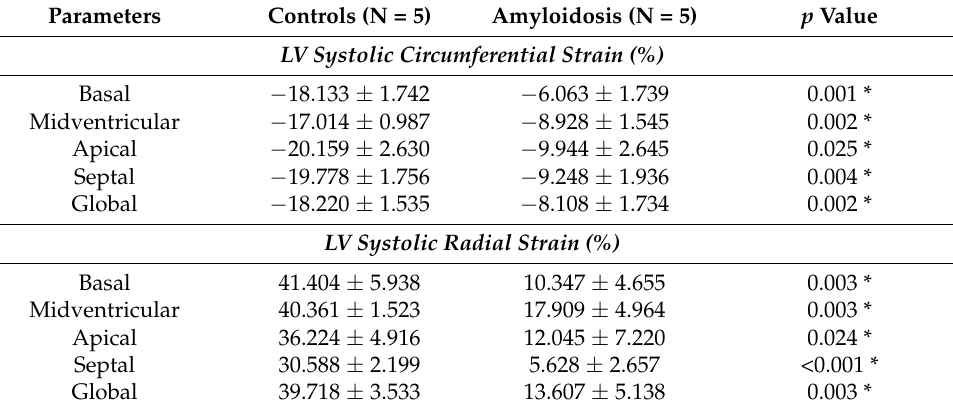
Figure 5. Strain curves illustrating right ventricular (RV) global changes in strain and strain rate over the course of one cardiac cycle. Representative strain curves were used from a normal patient, an AL amyloidosis patient, and an ATTR amyloidosis patient. ( A ) RV circumferential strain curves; ( B ) RV circumferential strain rate curves; ( C ) RV longitudinal strain curves; ( D ) RV longitudinal strain rate curves. SR S = peak systolic strain rate; SR D = peak diastolic strain rate. Table 2. Left ventricular (LV) strain and strain rate characteristics of amyloidosis patients compared to controls using cardiac